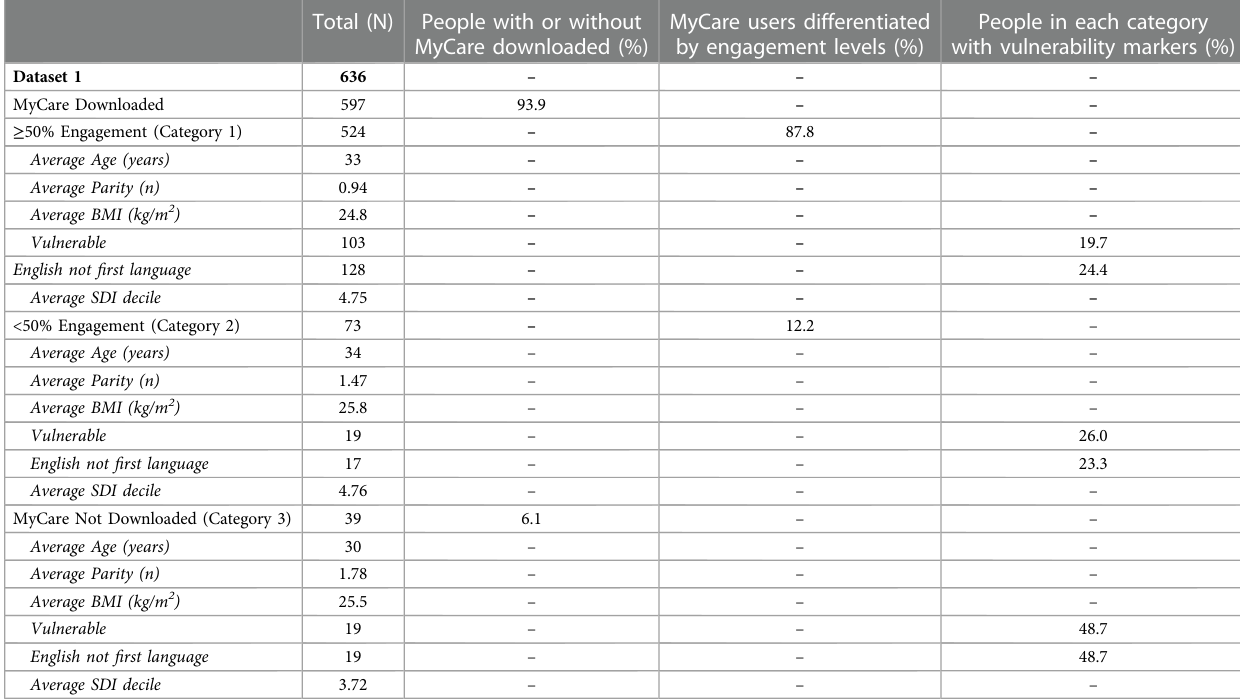
TABLE 1 The sociodemographic characteristics and vulnerability markers for categories 1, 2, and 3.